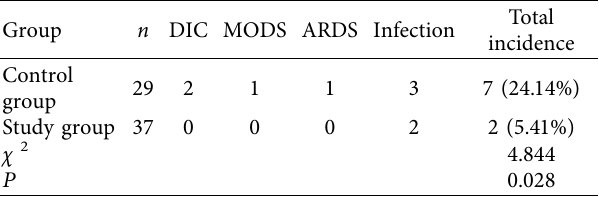
T Note. Compared with before treatment, ∗ P < 0 . 05. Table 4: Comparison of the incidence of complications in the control group and the study group within 3 days of treatment (cases,